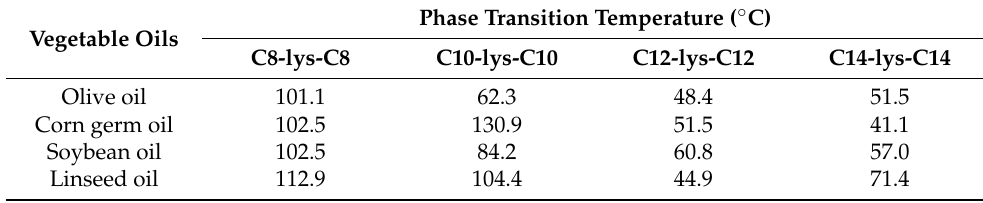
Table 4. The phase transition temperature of oleogels formed by L -lysine-based gelators. Vegetable